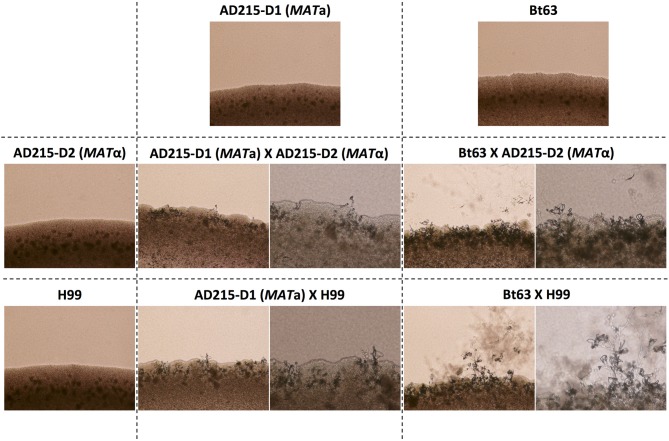
Successful mating between natural MATa and MATα isolates of Cryptococcus neoformans. Top: Images of solo cultures of a MATa colony of strain AD215-D1 and MATa tester strain Bt63; left: images of solo cultures of a MATα colony from strain AD215-D2 and MATα tester strain H99. All images of solo cultures were taken with 10× magnification. Images of pairwise mating between MATa and MATα strains are shown within the 2×2 grid: left, 10× magnification; right, 20× magnification. All crosses were carried out on MS medium.